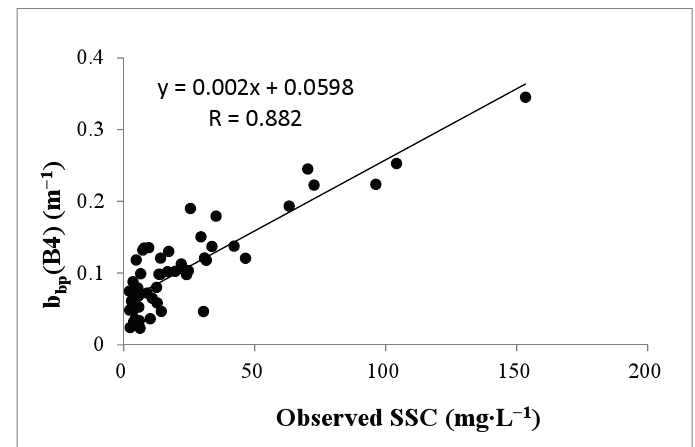
Figure 6. The relationship between inversed b bp using QAA and observed SSC. The two factors show a linear relationship (correlation coefficient r =